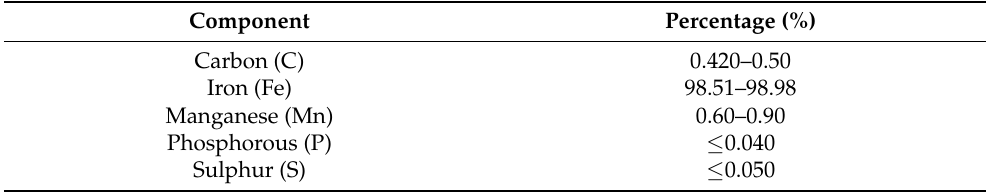
Table 1. Chemical properties for 1045 medium carbon steel [43].